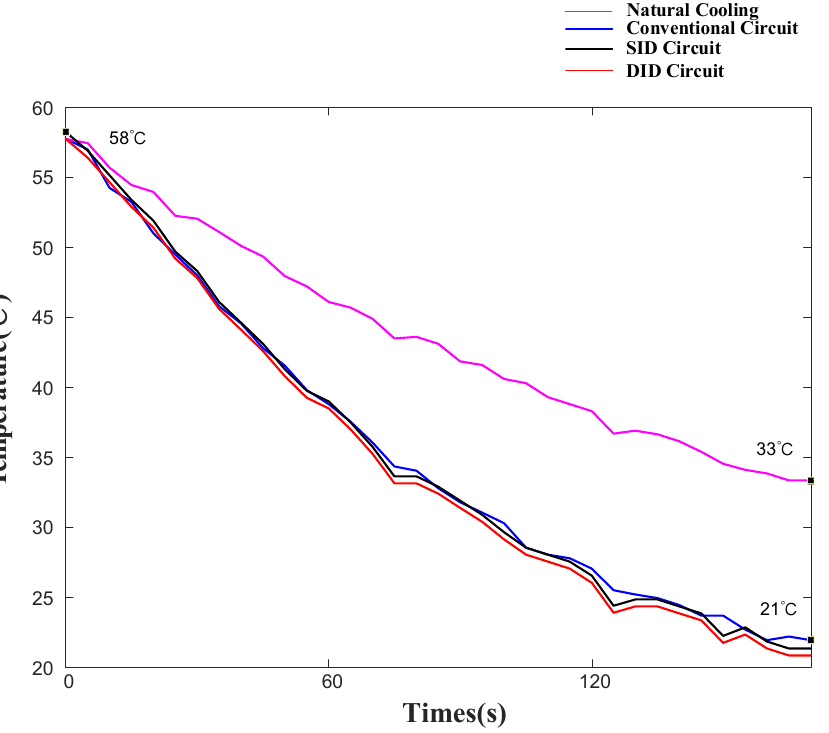
Figure 17. Surface temperature of rubber heating